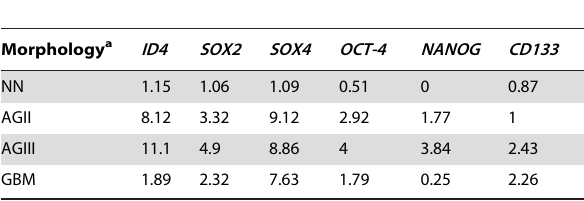
Table 2. Median of relative expression levels of the analyzed genes in astrocytomas, according to